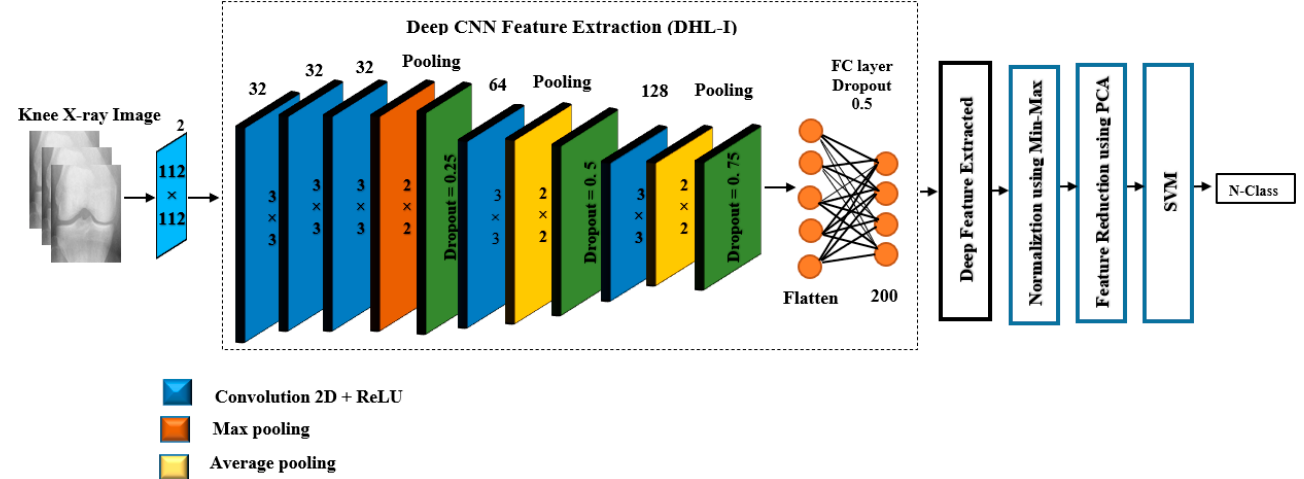
Figure 8. The proposed DHL-I for knee OA classification, based on KL grades. Deep Hybrid Learning-I (DHL-I)